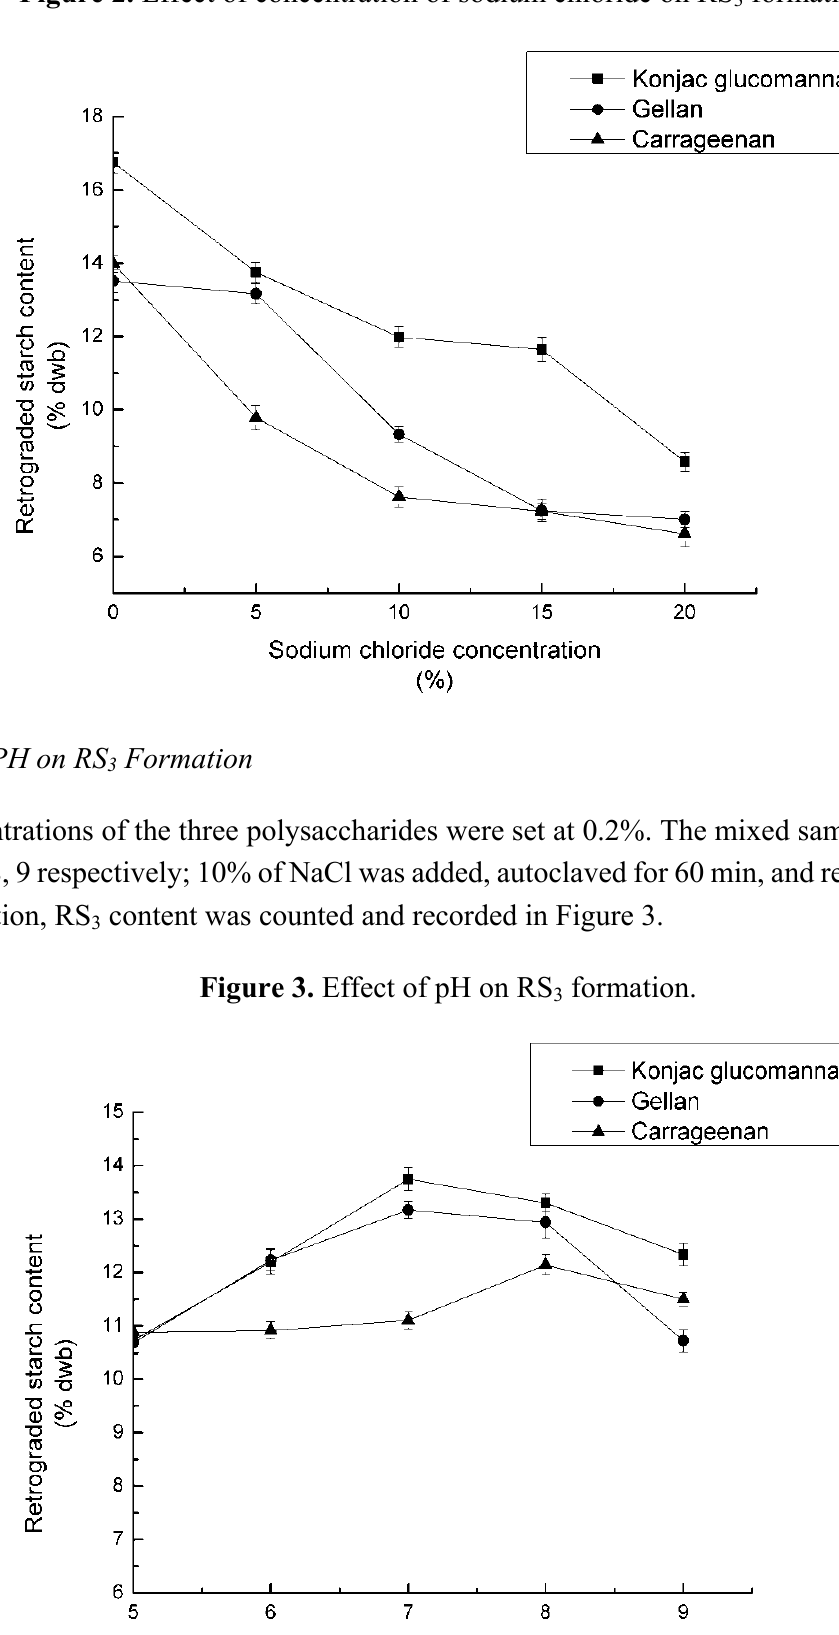
Figure 2. Effect of concentration of sodium chloride on RS